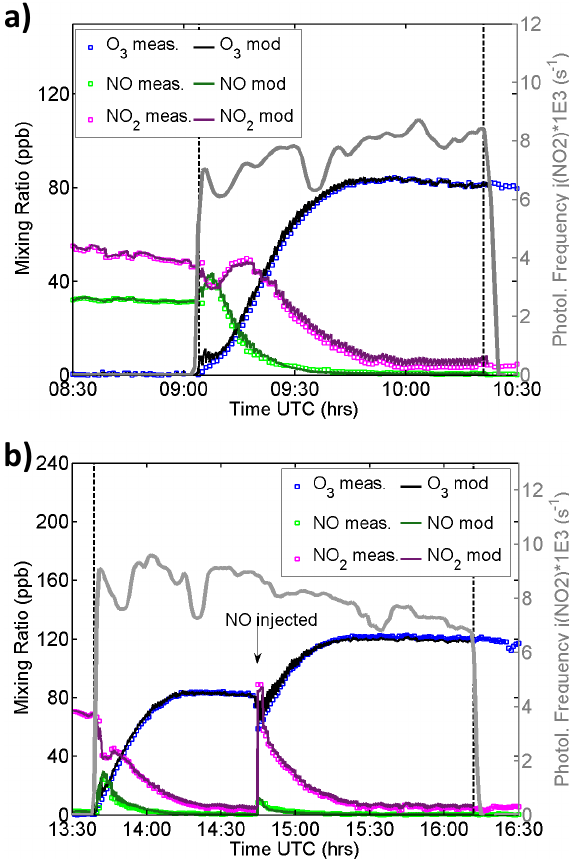
Fig. 1. Measured and modelled time series of O 3 , NO 2 , and NO mixing ratios in (a) experiments E1 and (b) experiment E2. The model was constrained by measured O 3 , NO 2 , and NO concentra- tions and therefore modelled mixing ratios coincide with measured ones. Photolysis frequency of NO 2 (scaled by 1 × 10 3 ) indicated by grey-shaded line. Vertical dashed lines indicate beginning and end of the sunlit